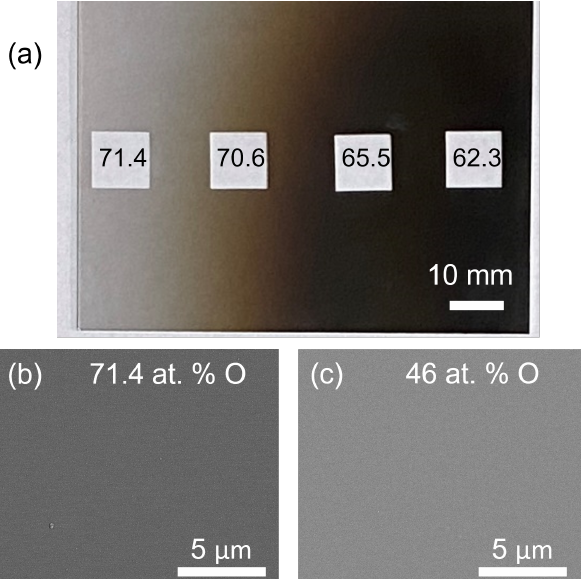
Figure 2. ( a ) Photograph of a glass plate on which Si substrates were placed during deposition at 12 mTorr. Uncoated squares are the locations of substrates, and the black numbers inside indicate oxygen content as determined by RBS. A transition from opaque to transparent occurs from the right to left of the photograph as the distance from the Ta sputter gun (which is centered ∼ 60 mm to the right of the edge of the plate) increases and oxygen content of films increases. Plan-view SEM micrographs of films with 71.4 and 46 at.% of O are shown in ( b , c ), respectively, demonstrating smooth surfaces across the full range of O